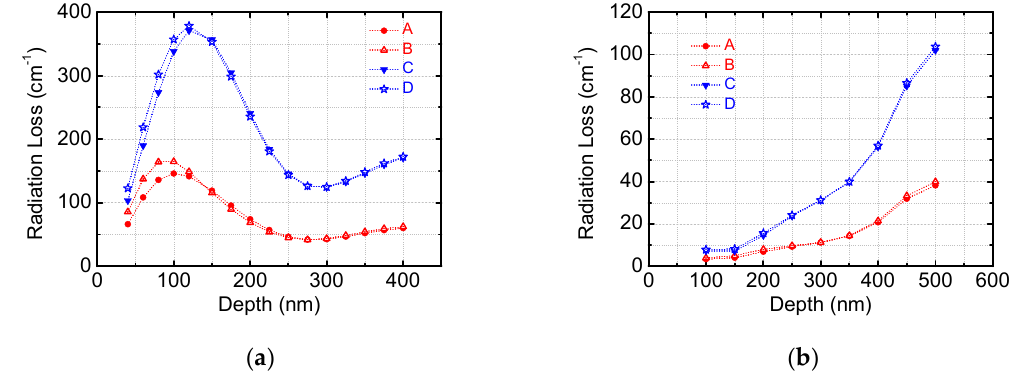
Figure 11. The radiation loss is investigated in terms of PC depth for ( a ) air-hole and ( b ) air-pillar PC-SELs assuming infinite cavity and RIT design with f = 0.25.